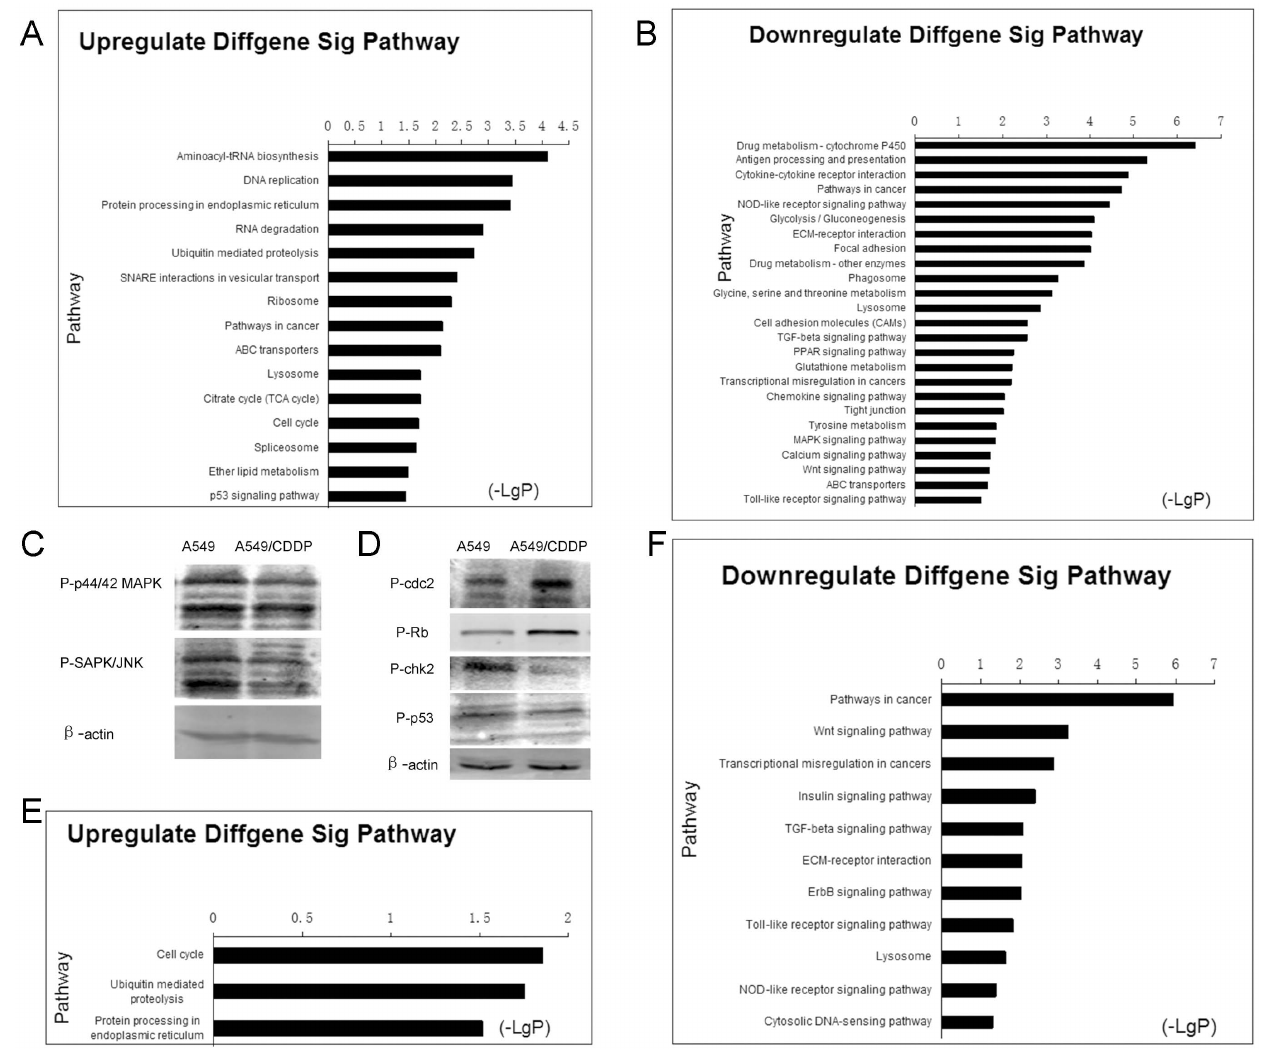
Figure 3. Signaling pathways of differentially expressed RNAs. Signaling pathways of differentially expressed upregulated mRNAs (A) and downregulated mRNAs (B). Western blot analysis of MAPK pathway (C) and Cell cycle pathway (D) levels in A549 cells and A549/CDDP cells. P-p44/42 MAPK, phosphor-p44/42 MAPK; P-SAPK/JNK, phosphor-SAPK/JNK; P-cdc2, phosphor-cdc2; P-Rb, phosphor-Rb; P-chk2, phosphor-chk2; P-p53, phosphor-p53. Signaling pathways on the intersection between differently expressed mRNAs and predicted target genes from differently expressed upregulated mRNAs (E) and downregulated mRNAs (F). Pathway analysis was predominantly based on the KEGG database. P-values , 0.05 using the two-sided Fisher’s exact test were classed as being statistically significant. The vertical axis represents the pathway category and the horizontal axis represents the -log10 (p value) of these significant pathways.